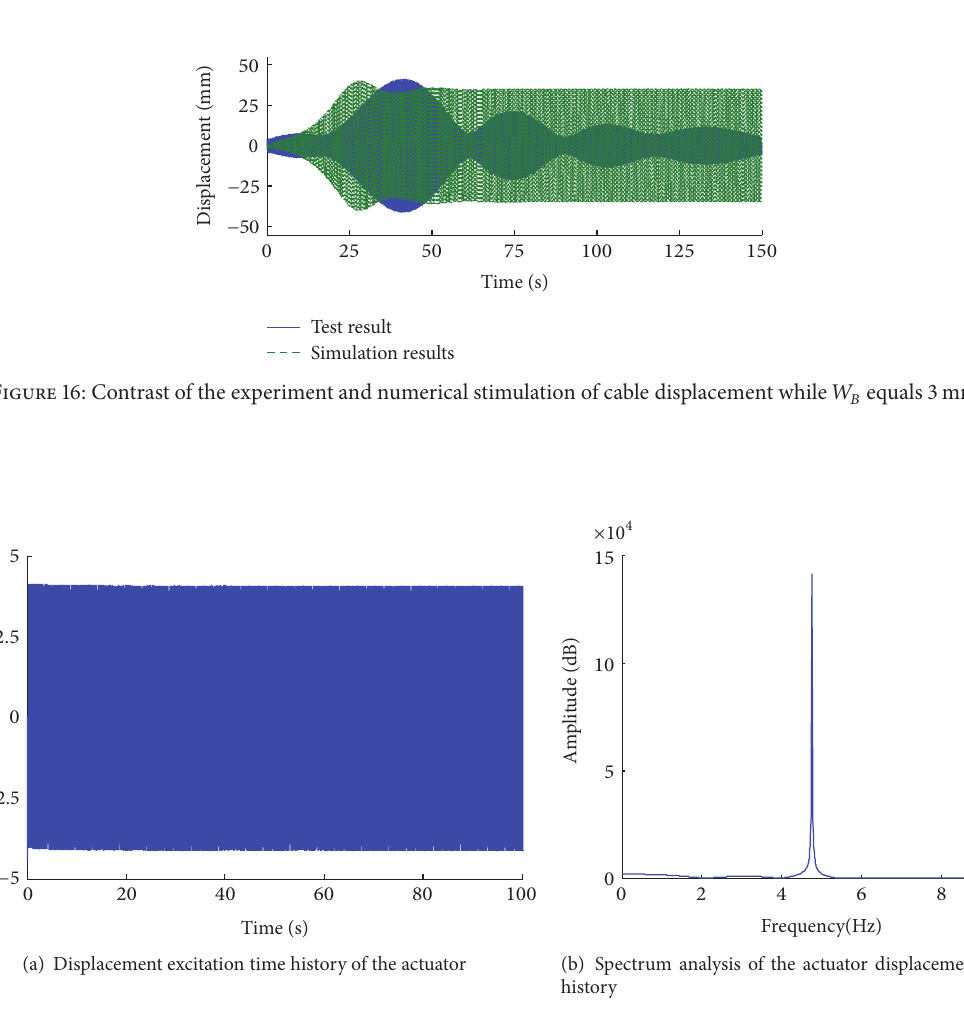
Figure 17: Displacement time history and its amplitude-frequency curve of the